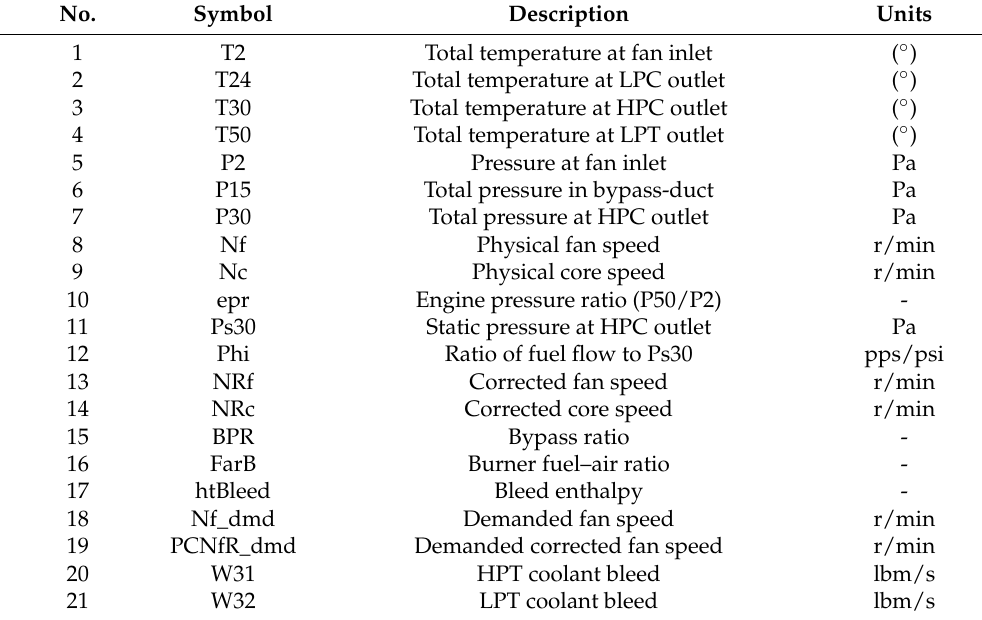
Table 9. C-MAPSS outputs to measure system